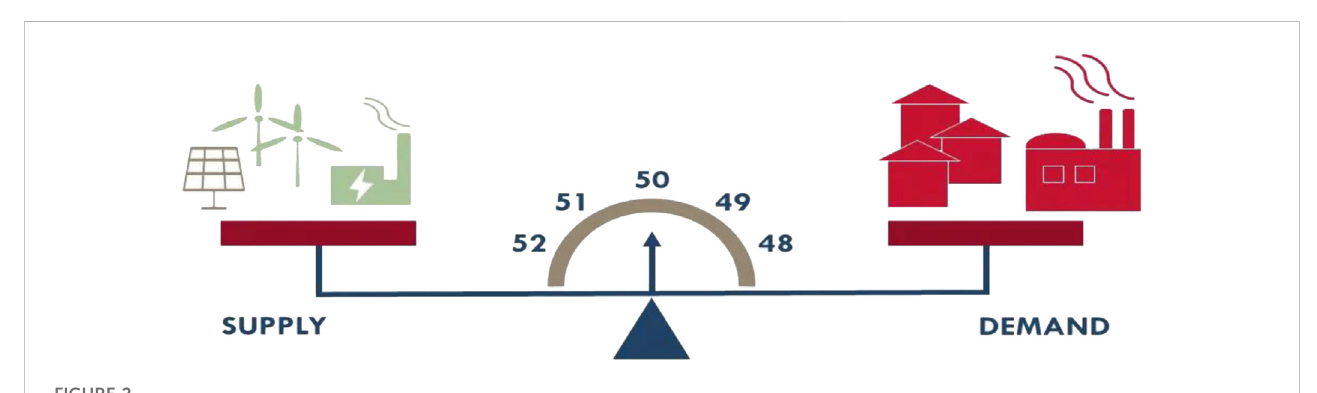
FIGURE 1 Energy management system in MG.